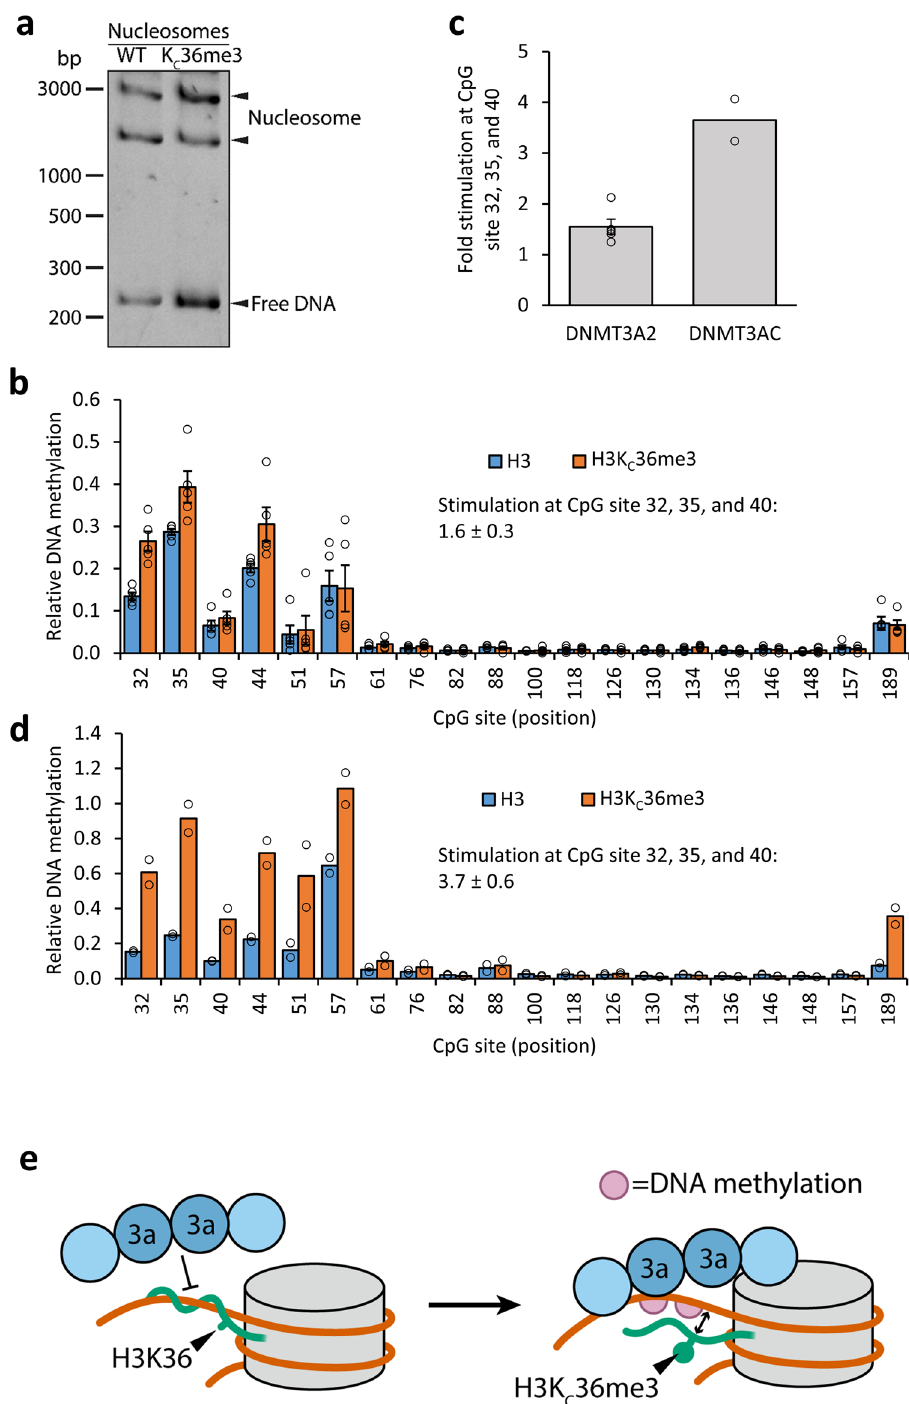
Fig. 4 H3K C 36me3 recognition and details of the methylation pattern on the linker DNA. a Gel shift assay of unmodi fi ed and H3K C 36me3 containing nucleosomes. Successful nucleosome reconstitution is con fi rmed by the prominent shifted DNA bands. b Relative CpG site methylation levels observed in fi ve independent competitive methylation experiments of unmodi fi ed and H3K C 36me3 nucleosomal substrates with DNMT3A2. For comparison, the activities in the independent reactions were normalized to the average activity on unmodi fi ed nucleosomes. Error bars represent the SEM. c Ratio of the methylation levels of unmodi fi ed and H3K C 36me3-containing nucleosomes for the three most strongly methylated CpGs with DNMT3A2 and DNMT3AC. H3K C 36me3 nucleosome methylation is 1.5-fold increased in the case of DNMT3A2 ( p -value: 1.15 × 10 − 4 , based on a two-sided T-Test assuming equal variance). For the DNMT3AC, the ratio is more than 3.6-fold increased ( p -value: 2.32 × 10 − 3 , based on a two-sided T-Test assuming equal variance). Error bars represent the SEM if n ≥ 3. d Relative CpG site methylation levels observed in two independent replicates of the competitive methylation experiment of unmodi fi ed and H3K C 36me3 modi fi ed nucleosomes with DNMT3AC. e Schematic model of the inhibition of linker DNA methylation by H3-tail binding and the reduction of the H3-tail interaction with linker DNA by H3K36me3.